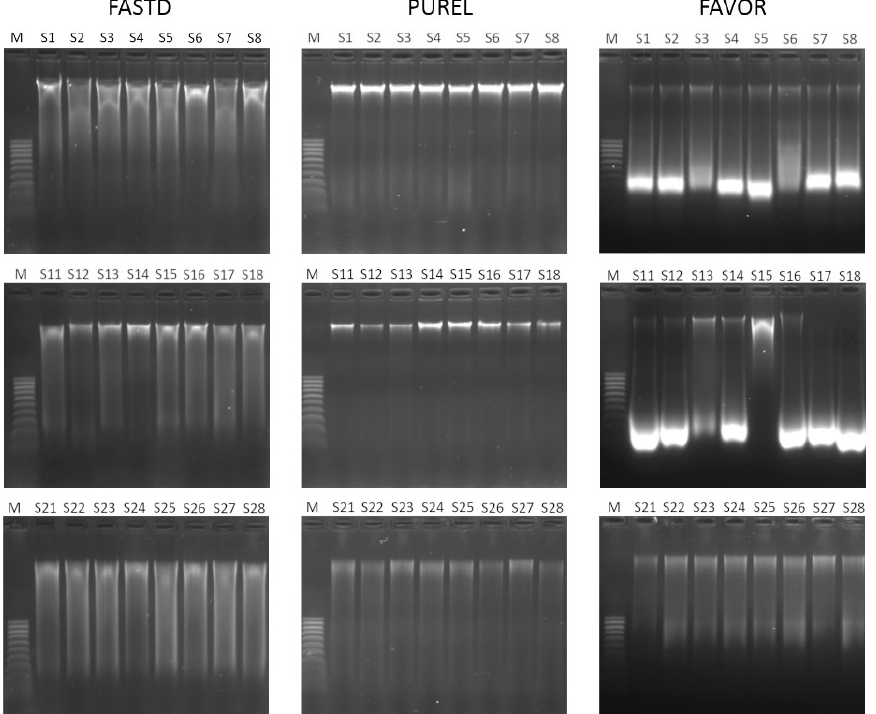
Figure 1. Result of metagenomic DNA electrophoresis. DNA was extracted using three kits (FASTD, PUREL, and FAVOR). DNA was extracted from activated sludge (S1–S8), biofilm (S11–S18), and digestate from an anaerobic reactor (S21–S28). M—molecular marker M110–M1000 (Gdansk DNA).